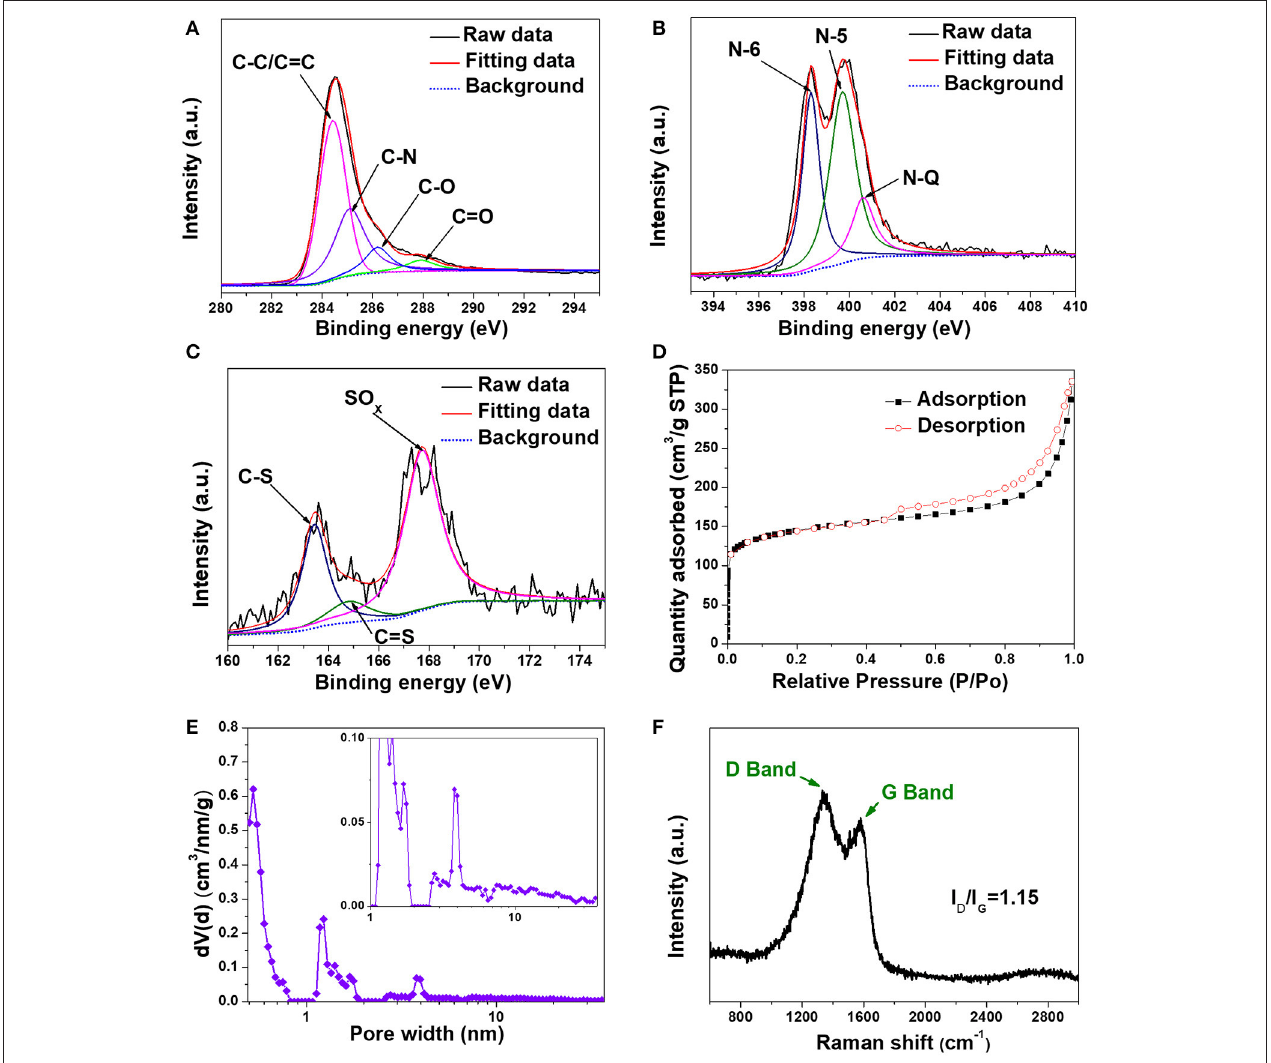
FIGURE 3 | Structural characterization of H-2D-HCA. (A) High-resolution XPS spectrum of C1s; (B) High-resolution XPS spectrum of N1s; (C) High-resolution XPS spectrum of S2p; (D) N2 adsorption/desorption isotherms; (E) Pore-size distribution curve and inset: enlarged pore-size distribution; (F) Raman